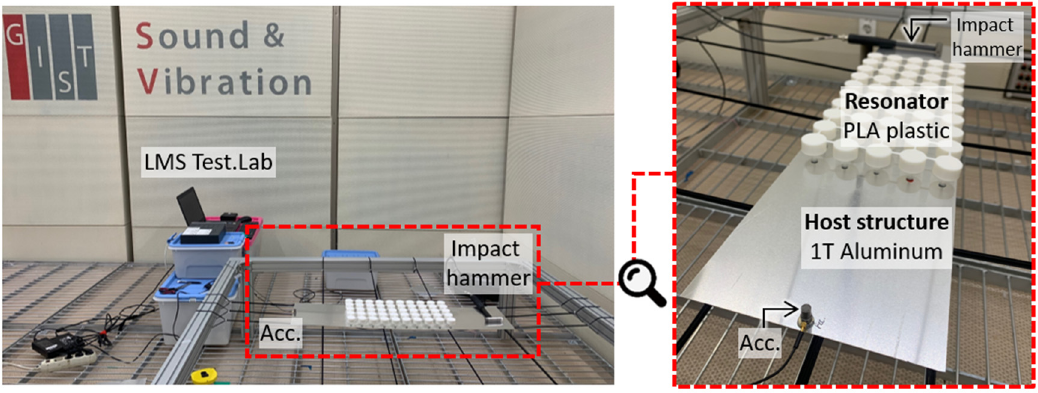
Figure 9. Experimental setup with multi-celled interconnected metamaterial structure .